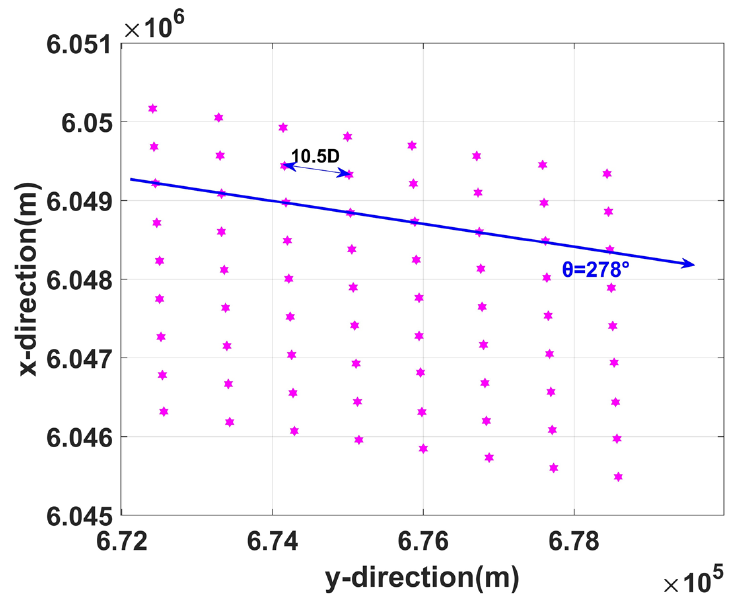
Figure 6. Layout of the Nysted wind farm.